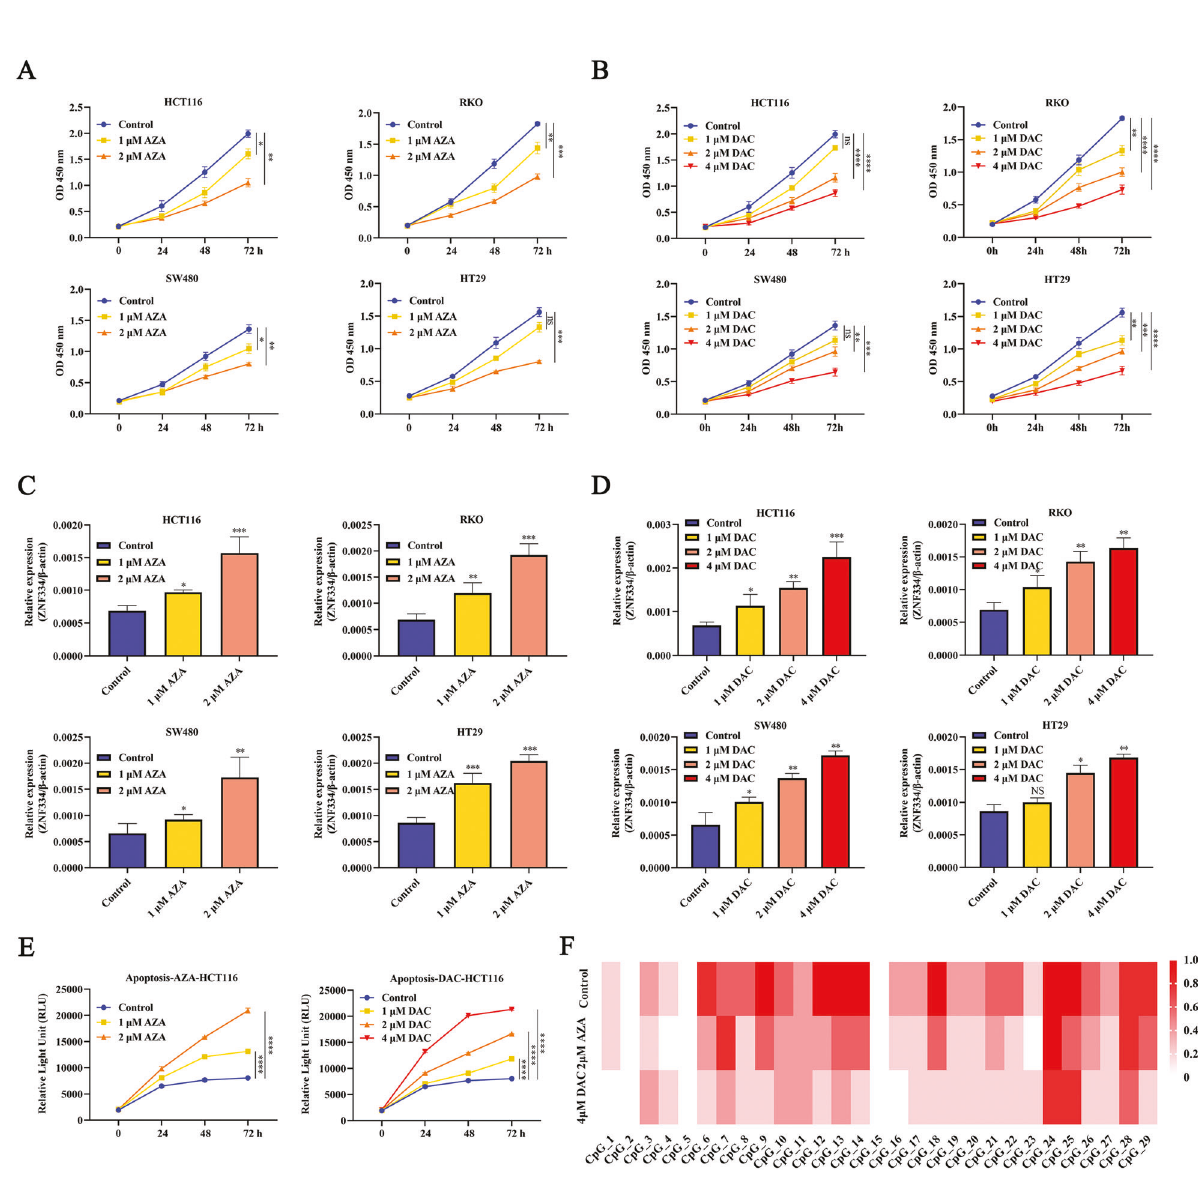
Fig. 2 Demethylation of ZNF334 using AZA and DAC in CRC. A , B A Cell Counting Kit-8 (CCK-8) assay was used to determine the growth of CRC treated with AZA and DAC ( n = 3). C , D ZNF334 mRNA expression in CRC after AZA and DAC treatment. Data are shown after normalization to β -actin ( n = 3). E Relative Light Unit was performed to detect apoptotic cells of HCT116 and RKO cells after AZA and DAC treatment ( n = 3). F Genomic DNA was extracted from HCT116 cells treated with AZA and DAC, then subjected to BSP. The promoter methylation of the ZNF334 gene was decreased in CRC cells treated with AZA and DAC after AZA and DAC treatment ( n = 5). (* p < 0.05; ** p < 0.01; *** p < 0.001; **** p < 0.0001, compared with the control group).